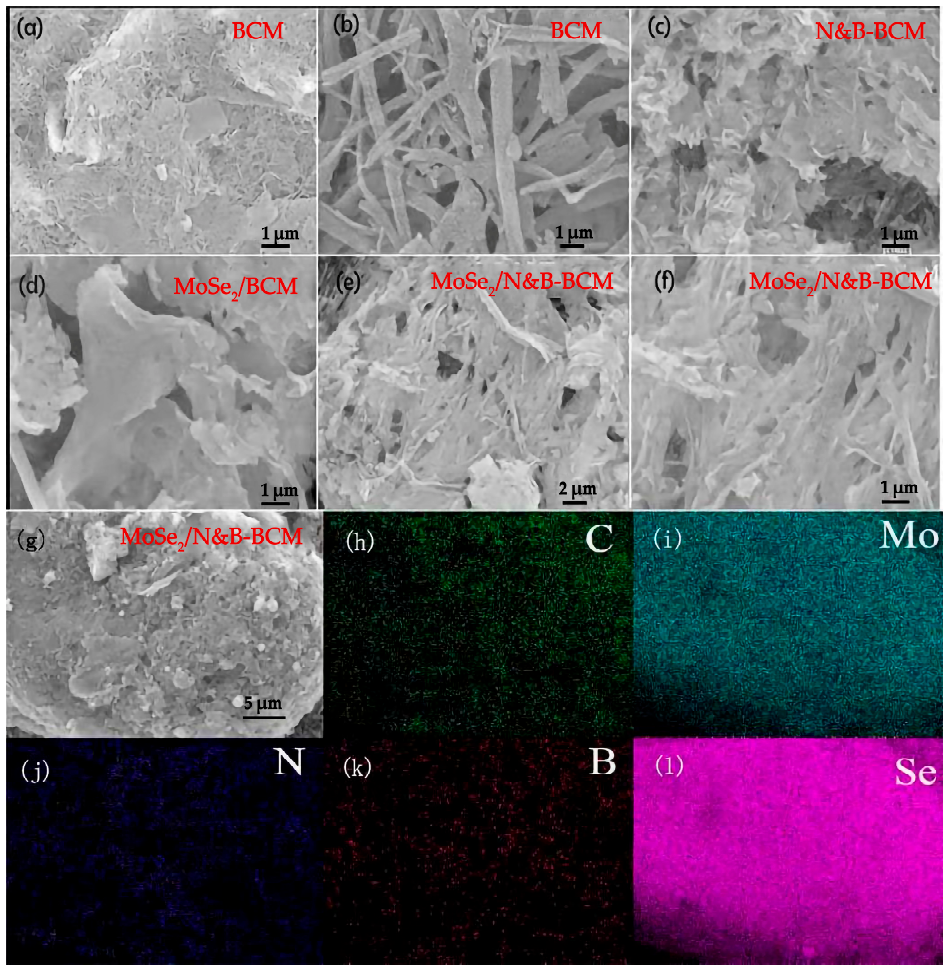
Figure 4. The SEM images of BCM ( a , b ); N&B-BCM ( c ); MoSe 2 / BCM ( d ); and MoSe 2 /N&B-BCM ( e – g ). The EDS images of MoSe 2 /N&B-BCM ( h – l ).